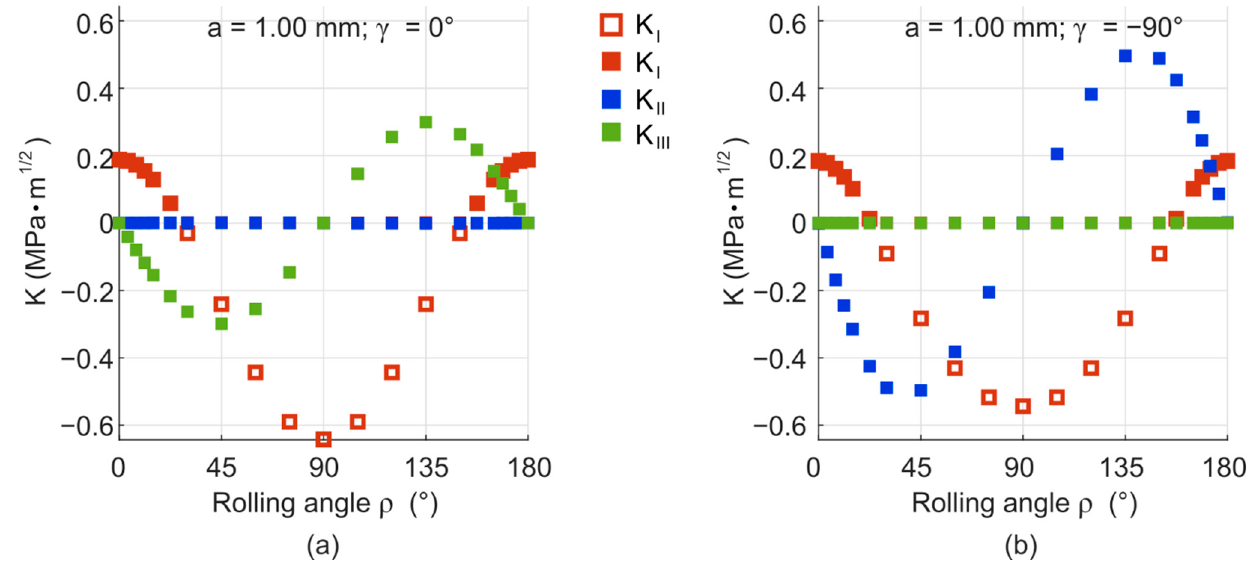
Figure A4. Course of stress intensity factors during rotation in the cylinder D × L = 6 × 6 mm 2 , load F = 350 N, a = 1.00 mm, position on the crack front; ( a ) γ = 0°; ( b ) γ = − 90°.